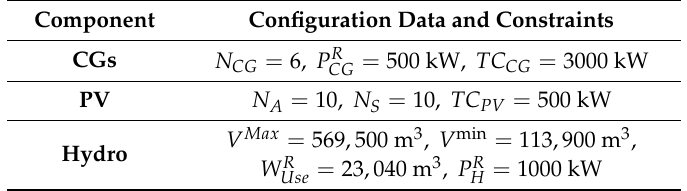
Table 1. Configuration Data of the Test system.